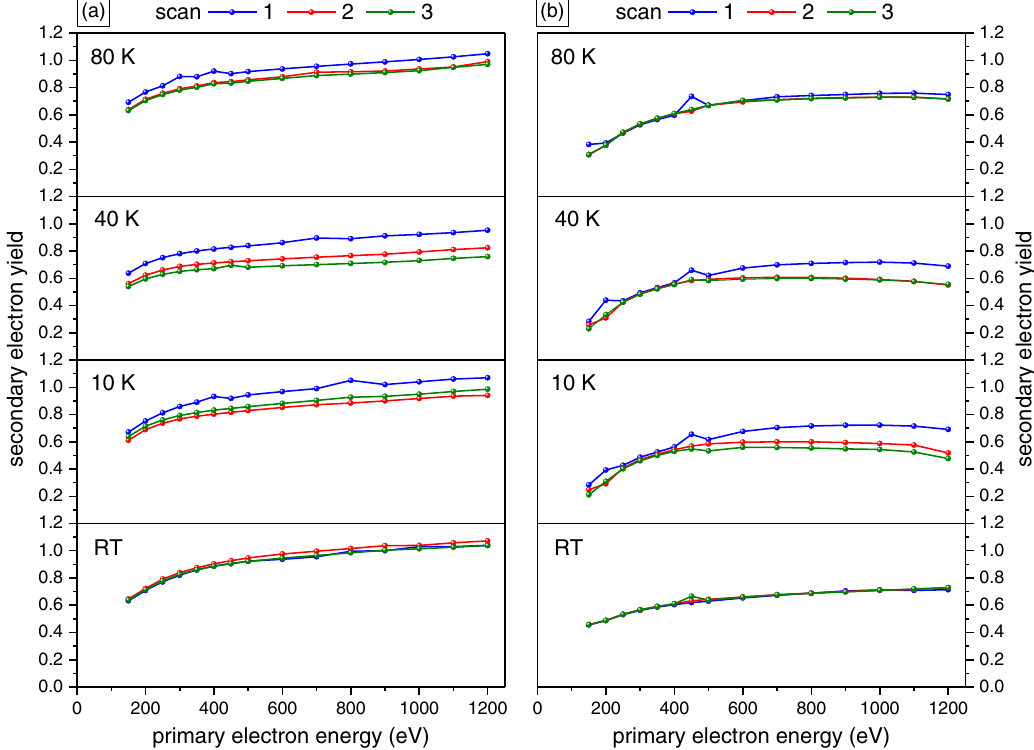
FIG. 2. (a) Variation of the energy dependence of the SEY for a CH-patterned air-treated sample, for three consecutive measurements at each temperature (RT denotes the measurements at room temperature). (b) Variation of the energy dependence of the SEY for a CH- patterned air-treated sample after thermal treatment and short air exposure, for three consecutive measurements at each temperature. The peak at 450 eV is an artifact of the